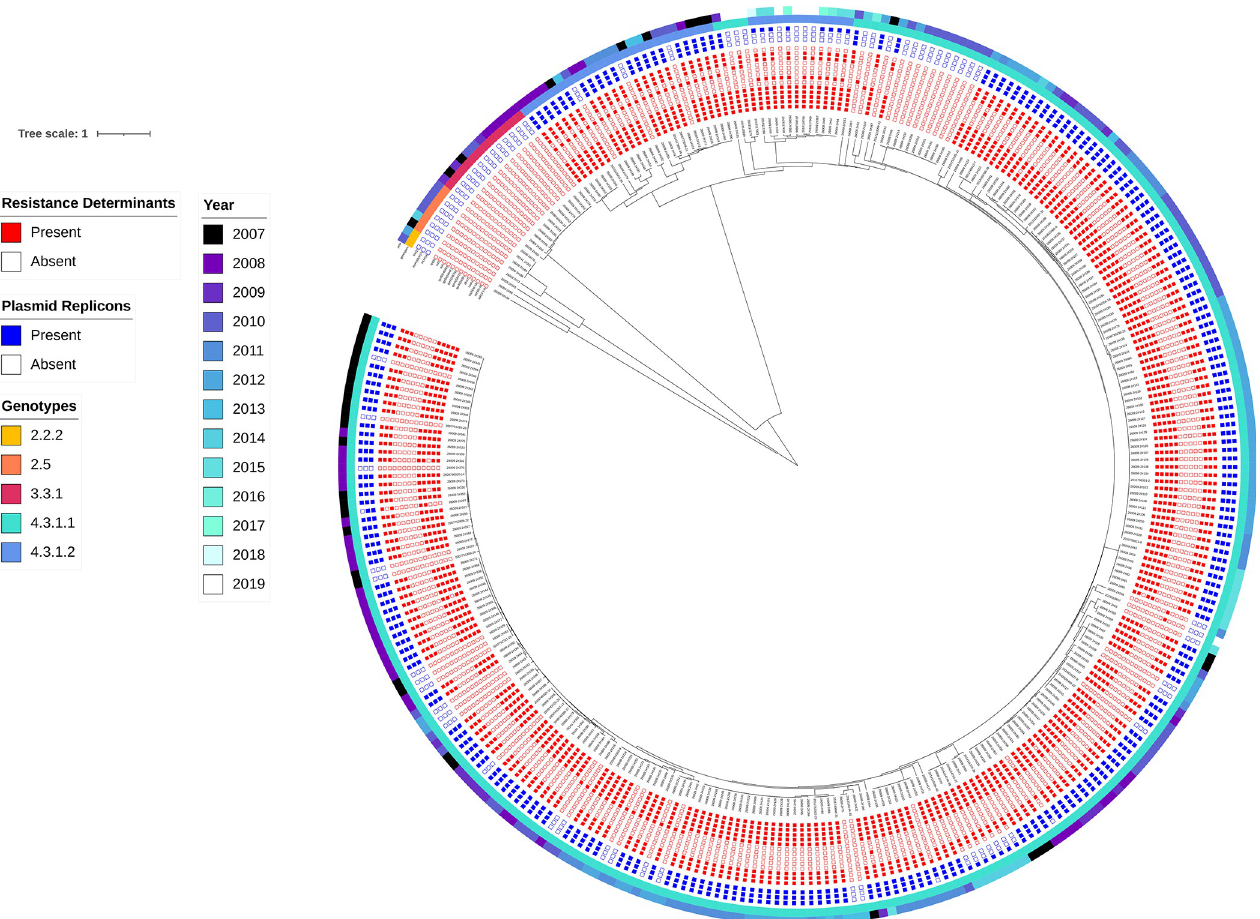
Fig 1. wgMLST tree of 310 isolates of S . Typhi isolates collected in the Kibera settlement in Kenya colected from 2007–2019. Displayed outside the tree (from inside to out) are the presence of antimicrobial resistance determiants (filled boxes in red), the presence of plasmid markers (filled blue boxes), genotyphi genotypes, and the year of